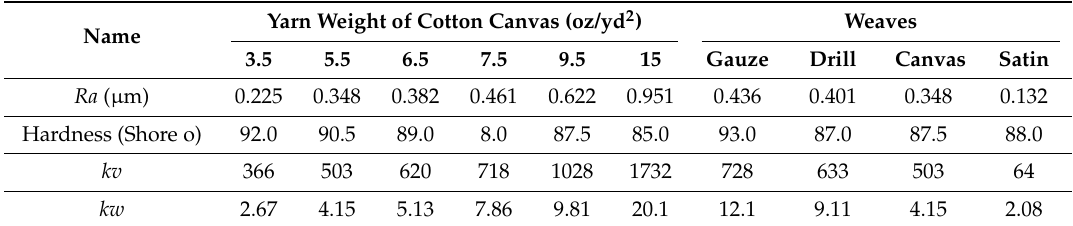
Table 1. Properties of fabric substrates as function of yarn weight and weave structure.